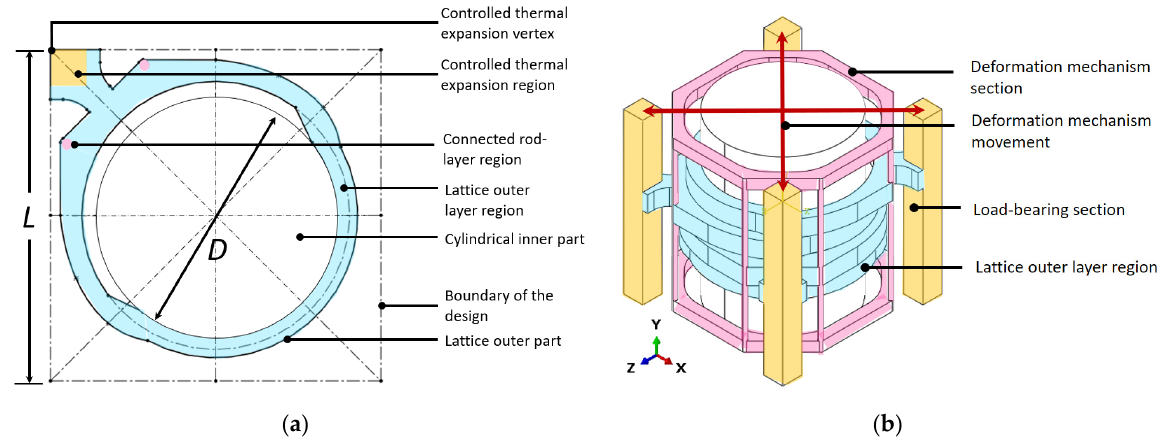
Figure 3. The concept of low-CTE design. ( a ) Top view of a drafted layer, where L is the original length of the lattice and D is the original diameter of the cylindrical inner part; ( b ) Isometric view of a unit cell (the two-way arrows indicate the deformation movement of the lattice).